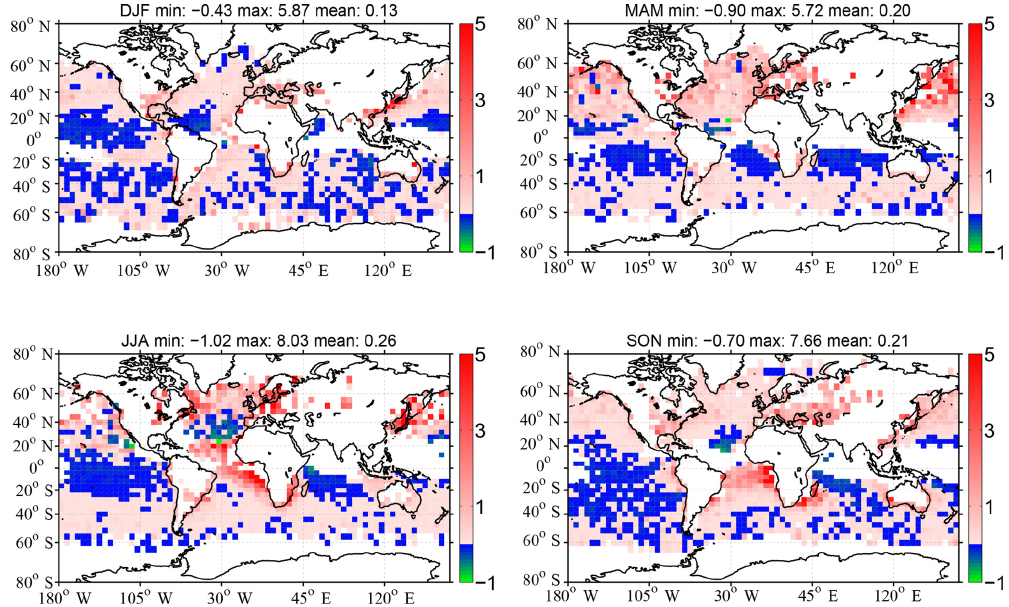
Figure 5. Global seasonal 4 ◦ × 5 ◦ TOA SW DARE OWC estimates (Wm − 2 , as described in Sect. 2.2). A white pixel is counted as DARE OWC = 0 in the global mean DARE OWC values in the title of each map. White pixels show a limited number of CALIOP OWCs, positive τ DR values or auxiliary MODIS–OMI–CALIOP combined satellite observations. The title of each map shows the global mini- AAC mum, maximum and mean